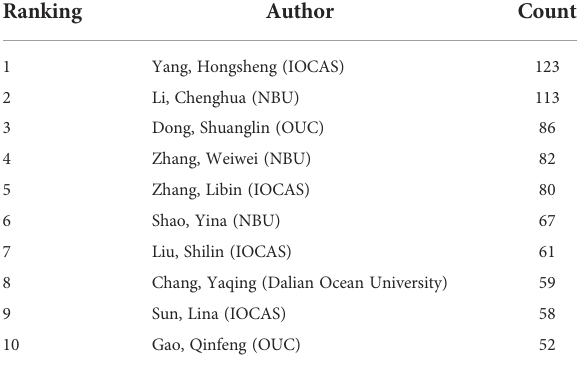
TABLE 1 Top 10 authors in the fi eld of Apostichopus japonicus from 2000 to 2021. Ranking